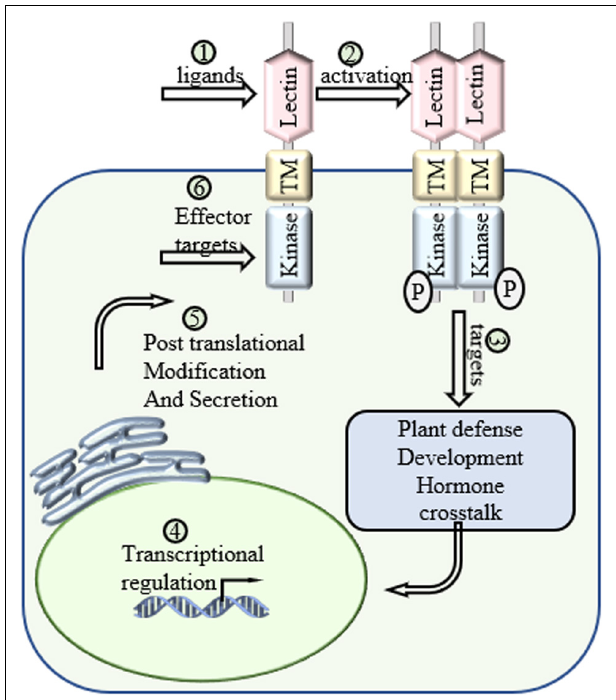
FIGURE 3 | Future directions of LecRLKs. As a cell surface receptor and signal transduction mediator, LecRLKs can perceive extracellular signals and trigger intracellular responses to protect the plant. (1) Determination of the ligands of LecRLKs could clarify the recognition between plant-microbe and plant-environment at the molecular level. (2) The activation of LecRLKs after signal perception. Several findings indicate the formation of homodimer/ heterodimer and auto-phosphorylation are required for LecRLKs’ kinase function. (3) The signaling pathways LecRLKs are involved in. Identifying their direct targets could be a very meaningful solution. (4) Transcriptional regulation of LecRLKs . Exploration of their dynamic transcriptional regulation mechanism could explain how they are induced during stress and help define their roles in plant growth and development. (5) LecRLKs have been found to be phosphorylated and N-glycosylated. Determination of post-translational modification could help our understanding of the functional dynamics of LectRLKs. (6) Some LecRLKs serve as key PRRs and are involved in PTI. There is a very high potential that virulence effectors might target them to suppress host